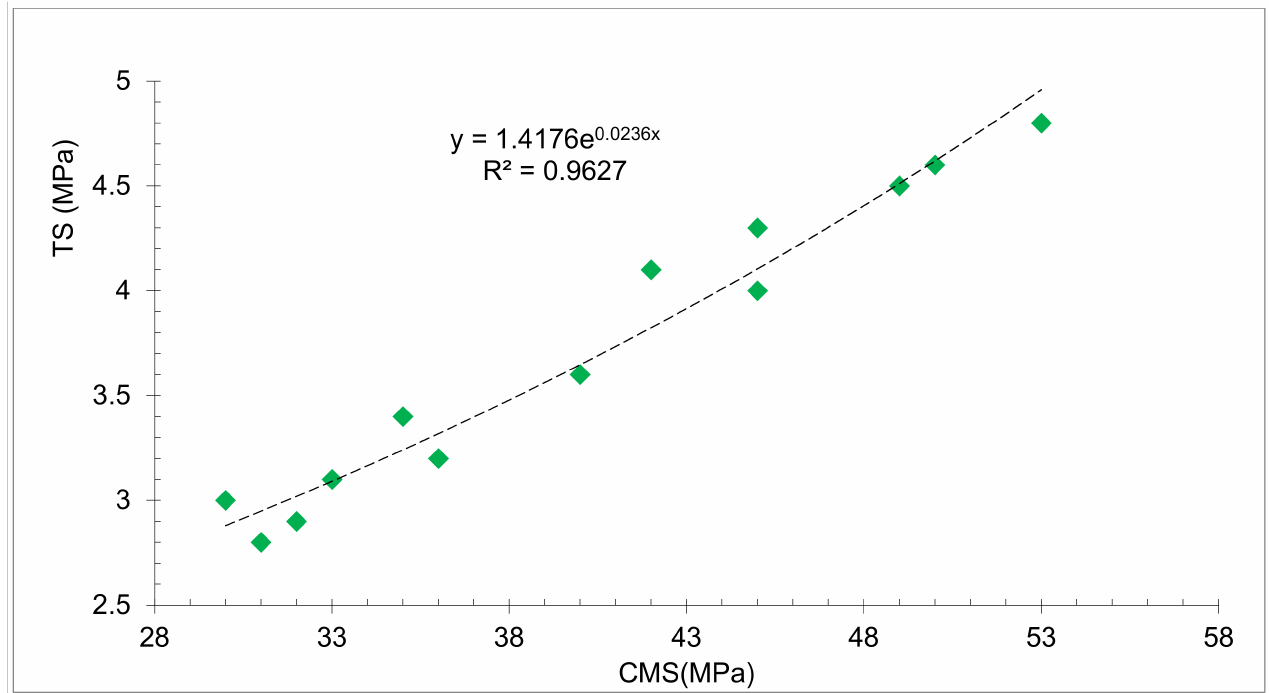
Figure 14. Correlation between Tensile and Compressive Strength: Data Source [44]. Green diamond is data